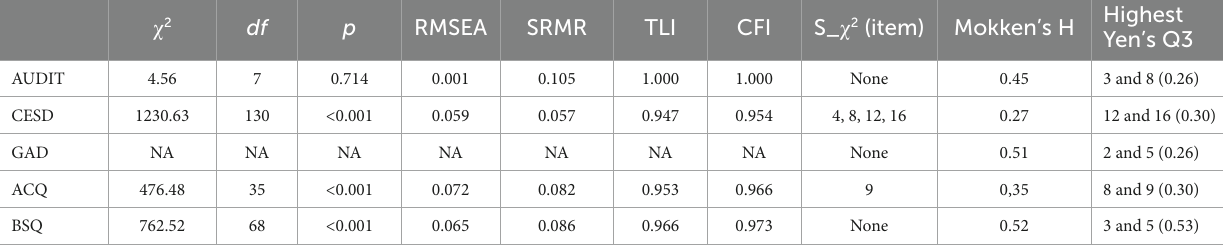
TABLE 6 Information on IRT model fit indices and item fit statistics for the measurement